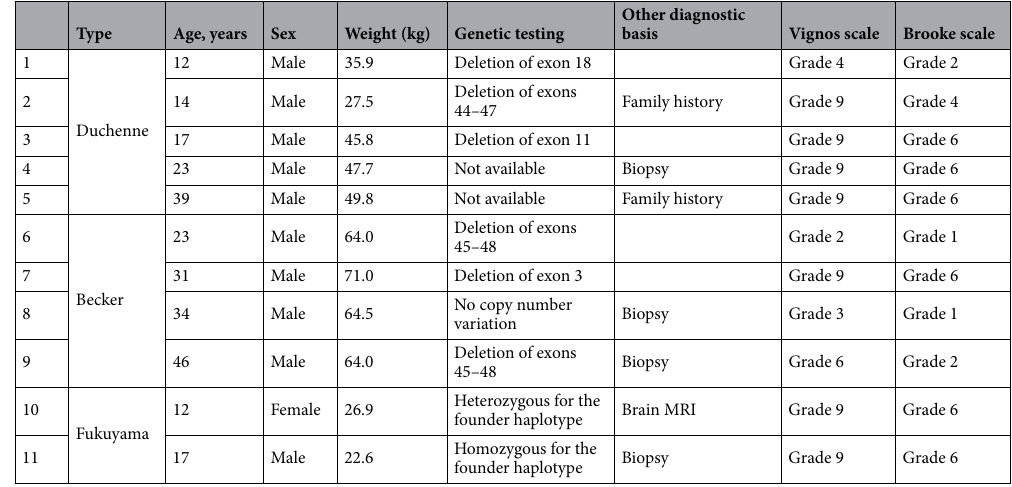
Table 1. Participants